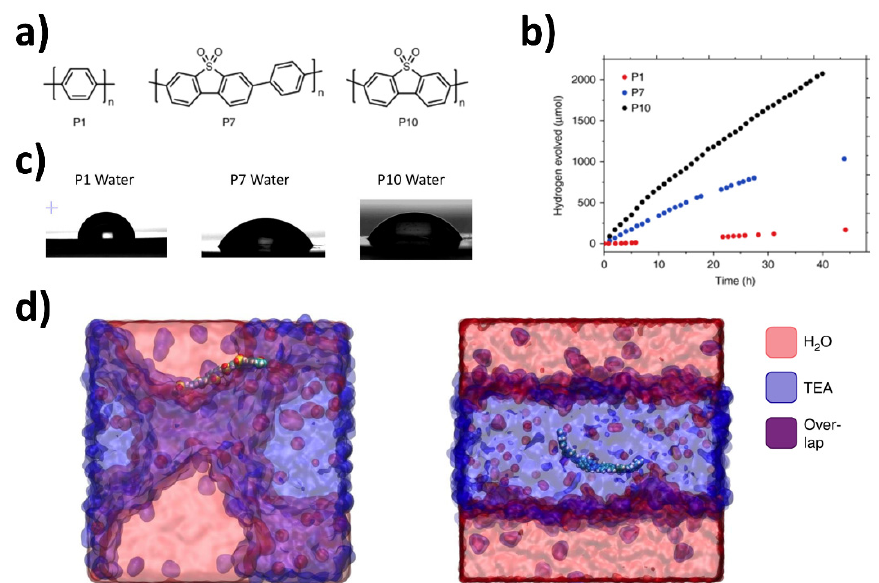
Figure 8. ( a ) Structures of P1, P7, and P10; ( b ) Photocatalytic hydrogen evolution experiments in water/methanol/triethylamine under visible light irradiation; ( c ) Contact angles against water for pellets of the polymers; ( d ) Snapshots of atomistic molecular dynamics simulations of oligomers of a the polar polymer P10 (left) and a non-polar fluorene polymer, as a model for P1, (right) both in a mixture of TEA (blue) and water (red) [Figure adapted from ref. [48] under CC-BY 4.0 International